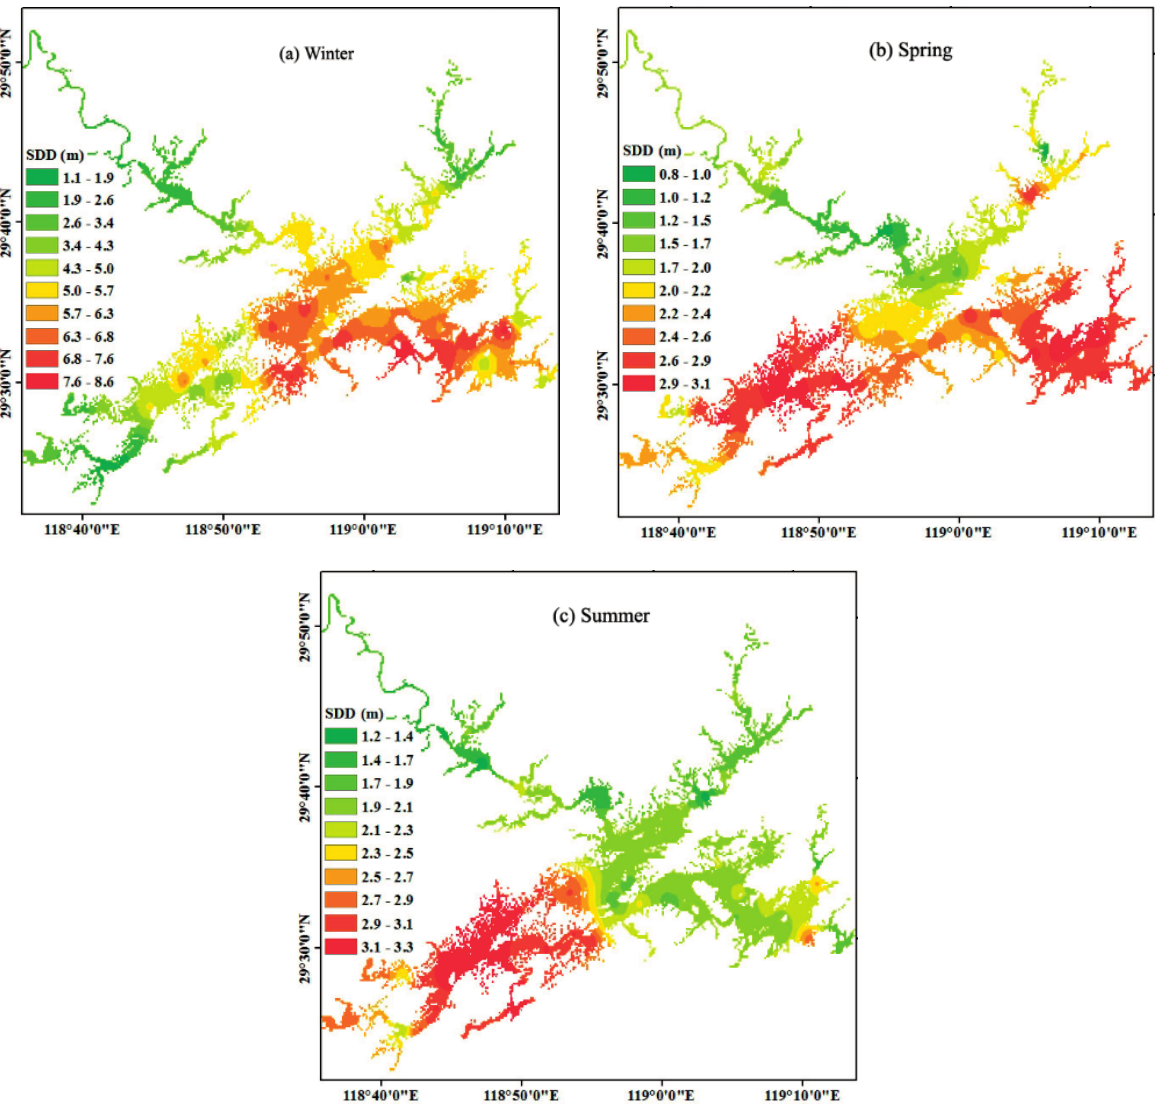
Figure 2. Spatial distribution of transparency in the winter of 2013 ( a ), spring of 2014 ( b ), and summer of 2014 ( c ) in Xin’anjiang